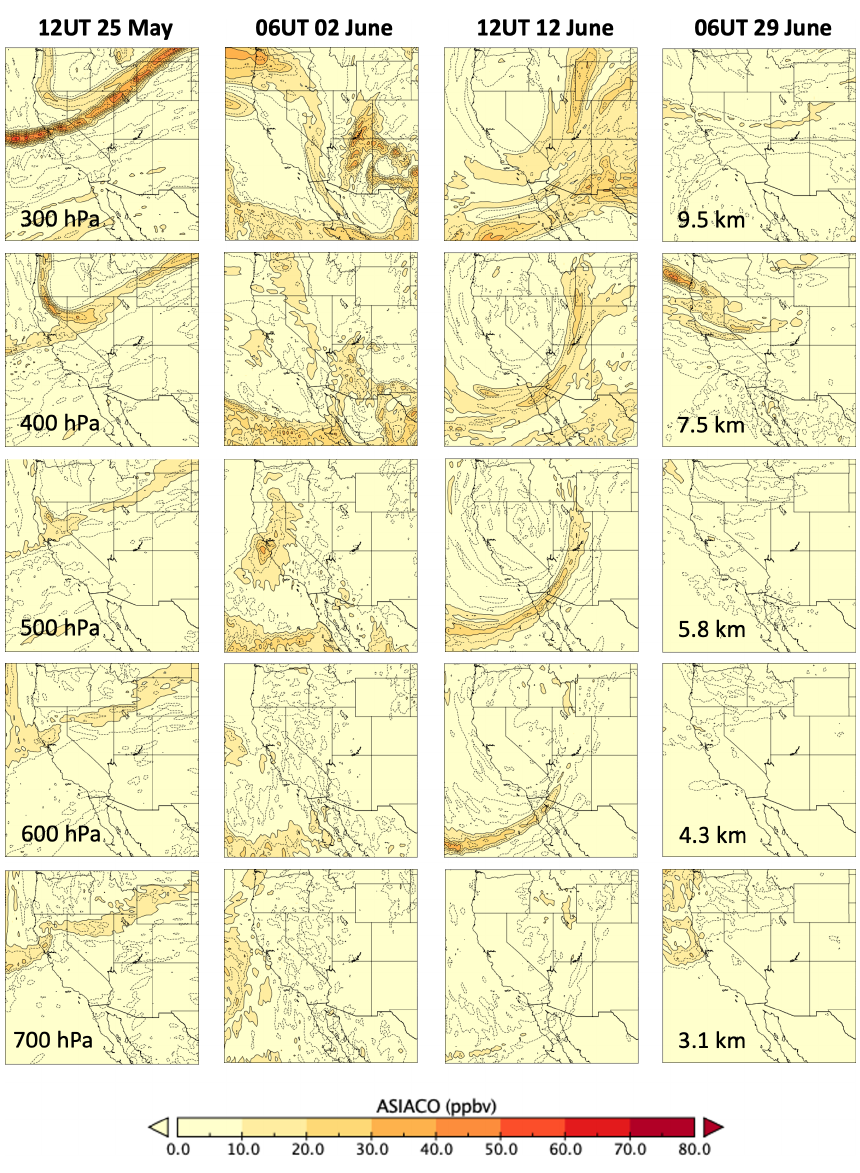
Figure 10. Same as Fig. 9, but for the ASIACO